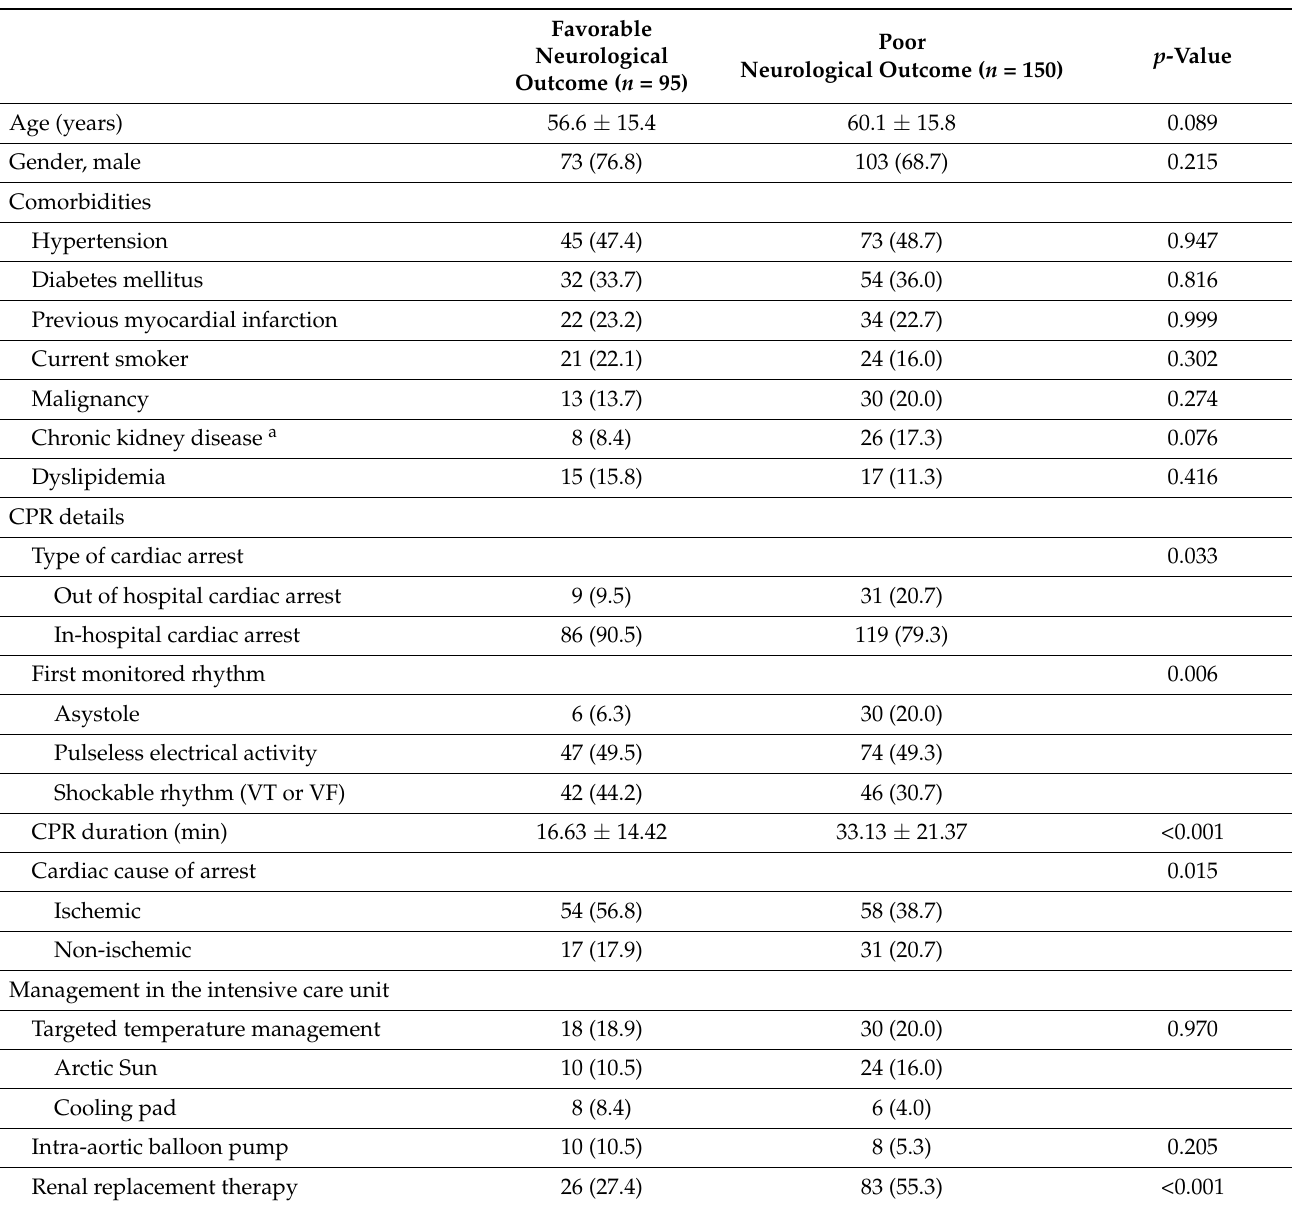
Table 1. Baseline characteristics of